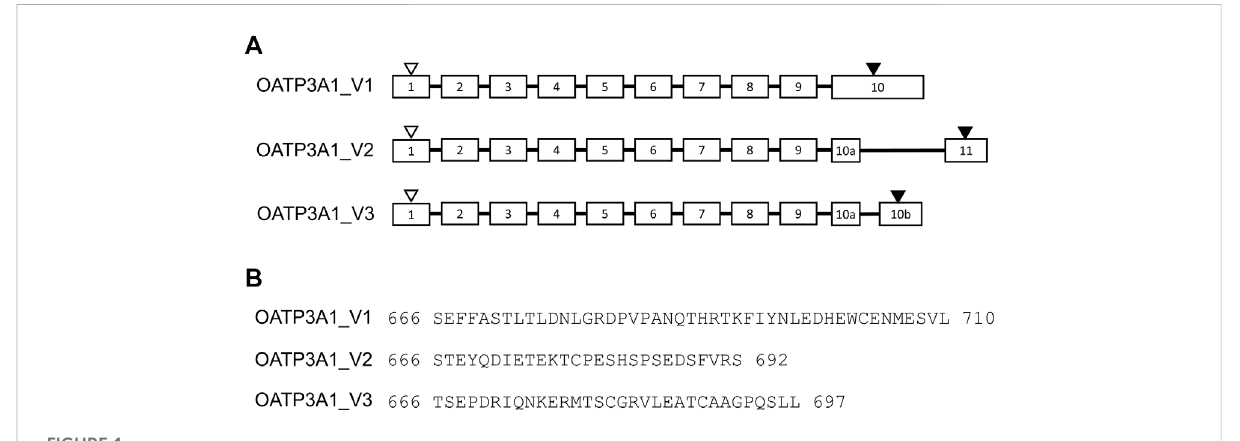
FIGURE 1 Exon – intron structure and amino acid sequence of the COOH terminus of OATP3A1 variants (OATP3A1_V1, OATP3A1_V2, and OATP3A1_V3). (A) .Exon – intronstructureofOATP3A1variants.Numberedboxesrepresentexons, andintronsareshownaslines. Thepositionsofthestartandstop codon are indicated by open and fi lled triangles, respectively. The fi gure is drawn on the basis of the alignment of transcript mRNA of OATP3A1_V3 with the human genomic sequence. (B) . Alignment of the C-termini of OATP3A1 variants.